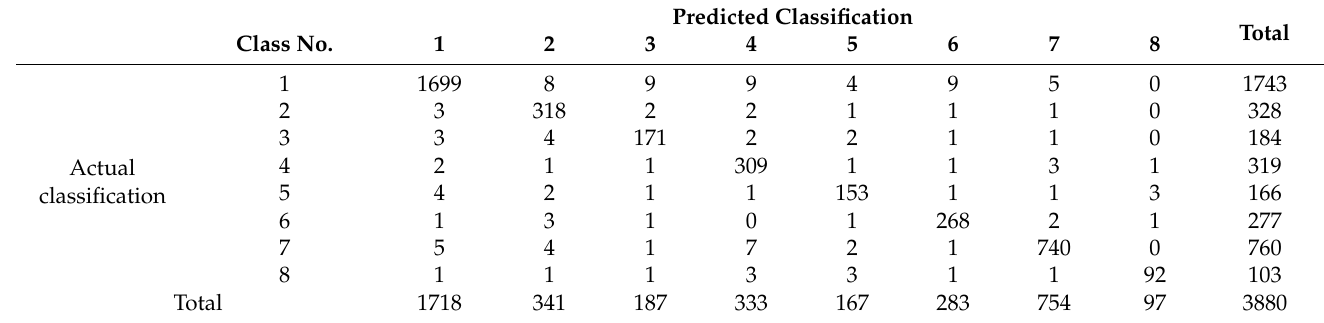
Table 7. The confusion matrix for Task 1 of accident type prediction.